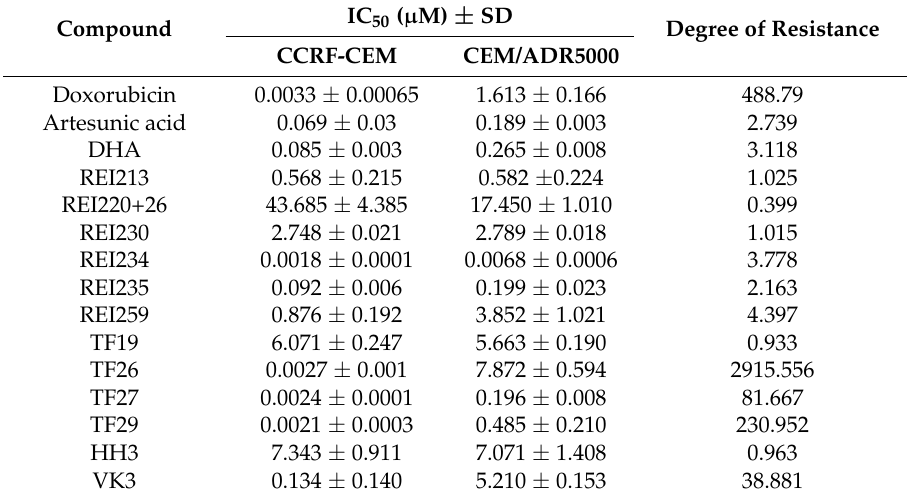
Table 1. The cytotoxicity of artesunic acid (ARTA) derivatives and doxorubicin. CCRF-CEM and P-glycoprotein-expressing CEM/ADR5000 cells were incubated for 72 h with artemisinin-, egonol-, and thymoquinone-based hybrids. Resazurin assays were performed to determine dose–response curves and IC 50 measurements were calculated (mean ± SD). Experiments were repeated at least twice. Resistance indices were obtained by dividing the IC 50 values on the resistant cell line through that of the sensitive cell